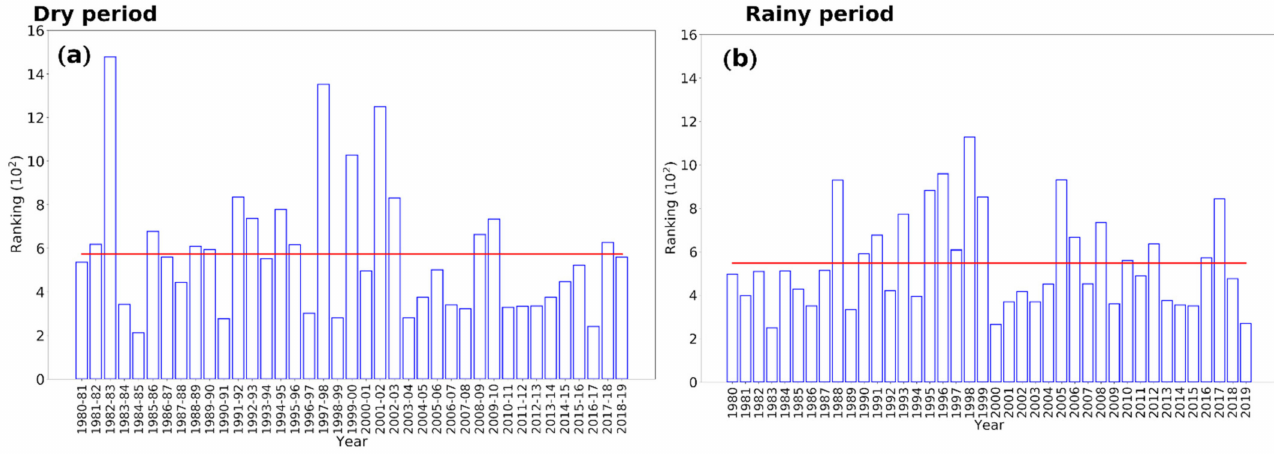
Figure 7. Mean seasonal ranking of extreme precipitation events for the dry ( a ) and rainy period ( b ). The dashed red line represents the mean ranking. Period is from 1980 to